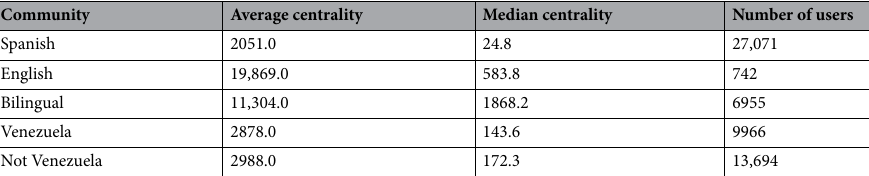
Table 5. The mean and median inter-community centrality of users in different communities. The centrality of the Spanish-speaking, English-speaking, and bilingual users is measured across the Spanish- and English- speaking communities, while the centrality of the inside-Venezuela and outside-Venezuela users is measured between the inside and outside Venezuela communities.